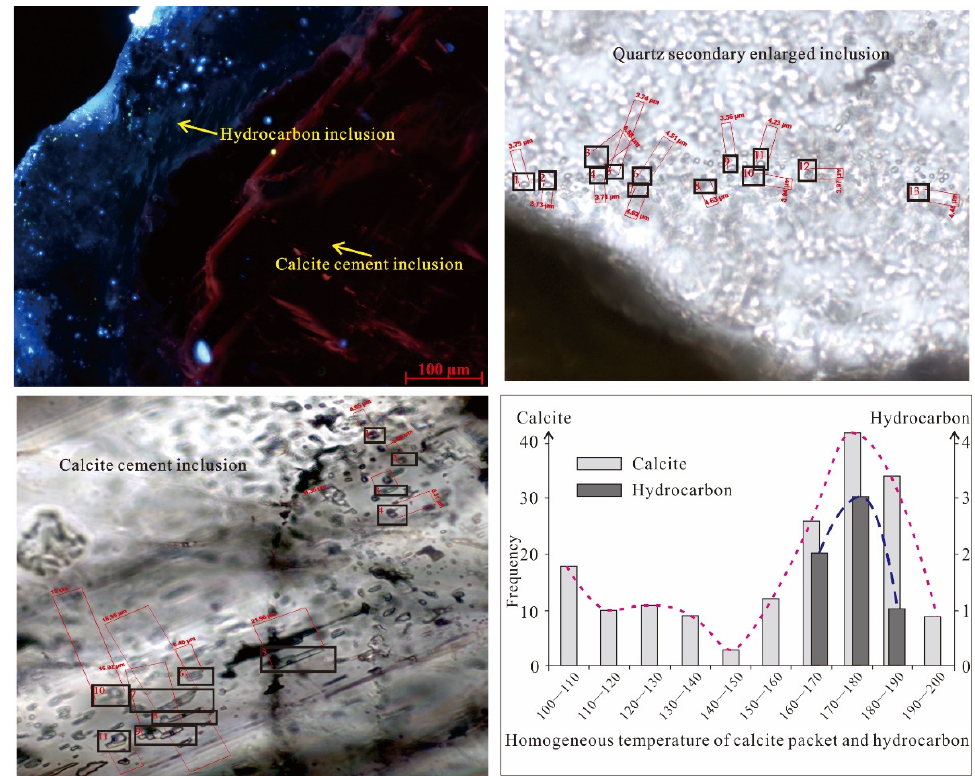
Figure 6. The microscopic characteristics and homogenization temperature range of the fluid in-